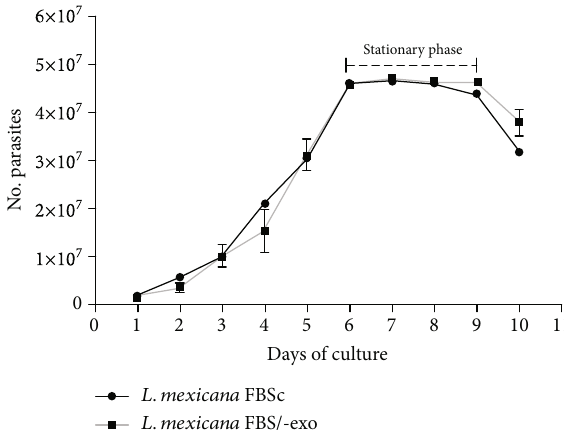
Figure 1: Exosomes derived from FBS are not required for growth of L. mexicana amastigotes. Parasite growth was analyzed in RPMI-1640 medium supplemented with normal FBS (control) or FBS/-exo for ten days. Data represent the meanof parasite number ± SD ( n = 3